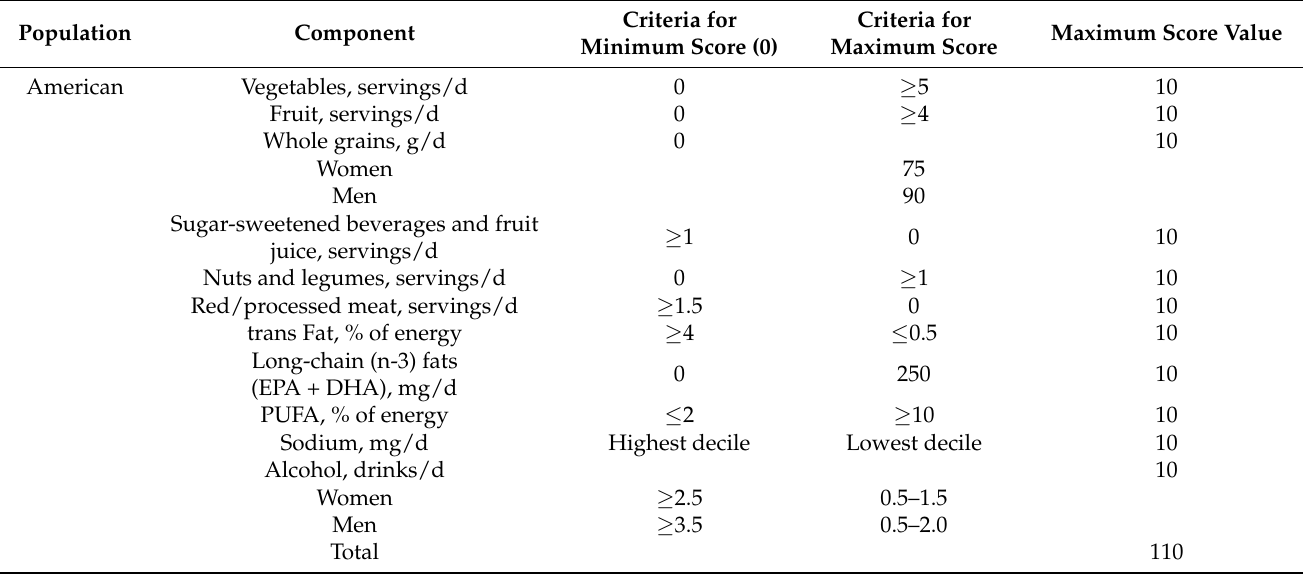
Table A2. Scoring method of the AHEI (2010).